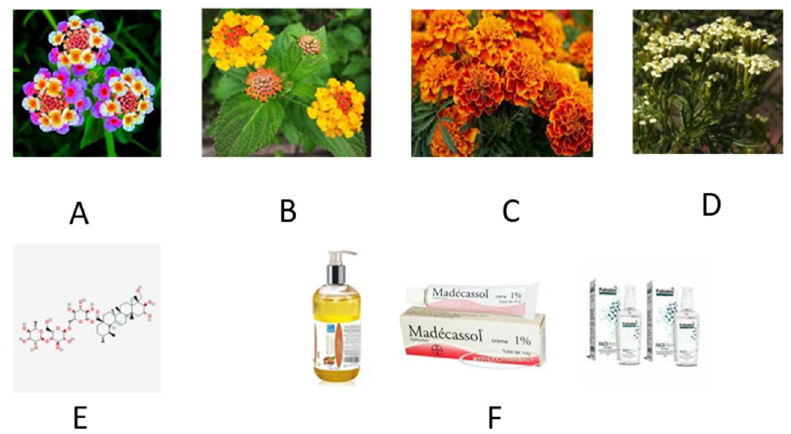
Figure 3. Generalities of the plant Lantana Camara and its products. ( A , B ) Inflorescences of Lantana camara . The flowers of this plant are found in many beautiful colors. The perfume of flowers and leaves is a sort of “ tutti-frutti-like ” smell that some people do not appreciate. However, the blooming is spectacular, with rich and extremely abundant flowers produced from late spring to fall, also in temperate areas. ( C , D ) Plants of marigold may belong to genus Calendula or Tagetes , and with respect to this which plant is used for which purpose is somewhat confusing. However, several species of Tagetes erecta are known, such as: African marigold, Aztec marigold, and French marigold, depending on their geographic origin. In any case, phyto-pharmacological studies have suggested that these plant extracts may have anti-viral, anti-genotoxic, and anti-inflammatory properties in vitro, and alcoholic extracts showed antibacterial activity and antifungal activities. In some areas of the world, Calendula petals and extracts are used as cosmetics, probably because they contain saponins, resins, and essential oils. In some areas of the world, they also find a culinary usage. ( E ) Chemical formula of the madecassol (molecular mass: 975.12) which is also known as madecassoside (of- ficial name) or asiticoside. It is a triterpenoid compound found in Centella asiatica and is used as a herbal medicament in traditional African medicine but also in Chinese and Ayurvedic medicine. Madecassoside has, allegedly, many biological activities, including anti-inflammatory, wound heal- ing, and antioxidant activities. The molecule is claimed to have a neuroprotective action, and there- fore may reduce stroke-derived damages. Madecassoside inhibits melanin synthesis, thus blocking ultraviolet-induced inflammation. ( F ) Commercial products of Madecassol such as skin regenerat- ing cream, cosmetic oil, and anti-acne-preparations.